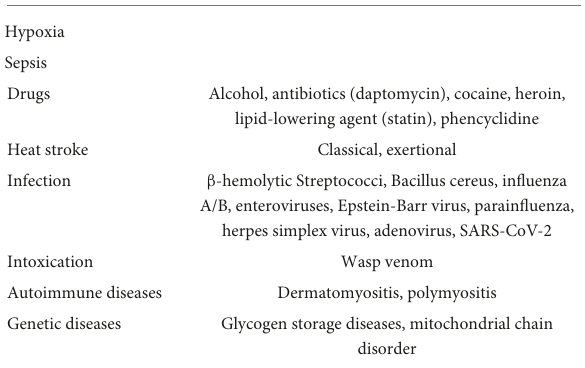
TABLE 2 Etiologies of concurrent rhabdomyolysis and liver